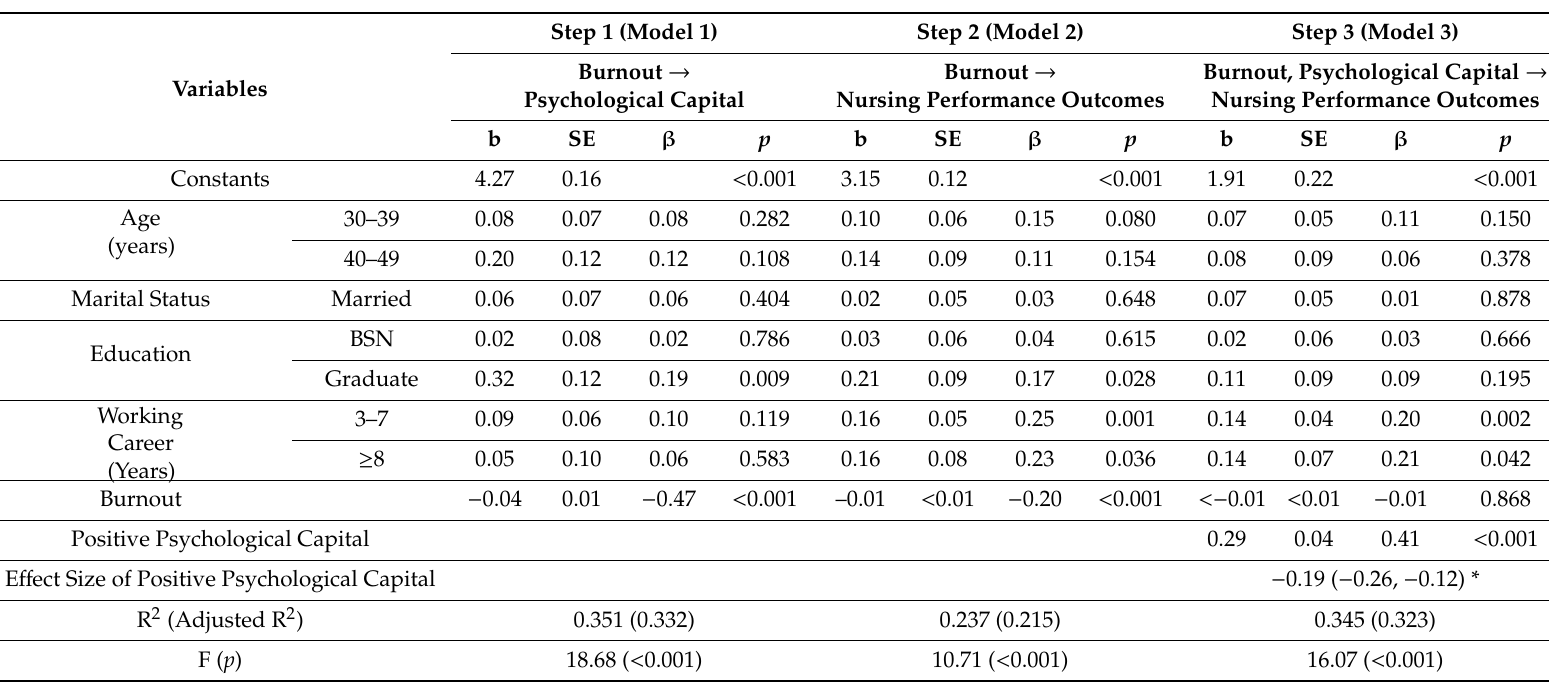
Table 3. Mediating e ff ect of positive psychological capital on the relationship between burnout and nursing performance outcomes ( n = 285).